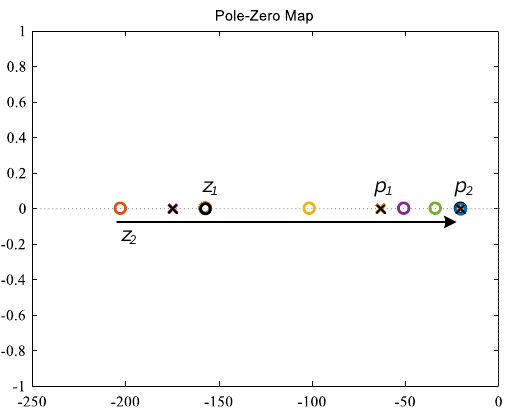
Figure 7. Zero-pole diagram of G r1 ( s ) with participation factor of direct power control λ varies. G r1 ( s ) has three poles and two zeros; the zero z 1 and the poles p 1 , p 2 , and p 3 are the same as the zero and poles of G r ( s ); and z 2 = – K ω /( λJ ω ω 0 ) is the new added zero point introduced by direct power control. As λ gradually increases from 0 to 5, z 2 approaches the origin along the negative real axis and finally becomes the dominant zero point.